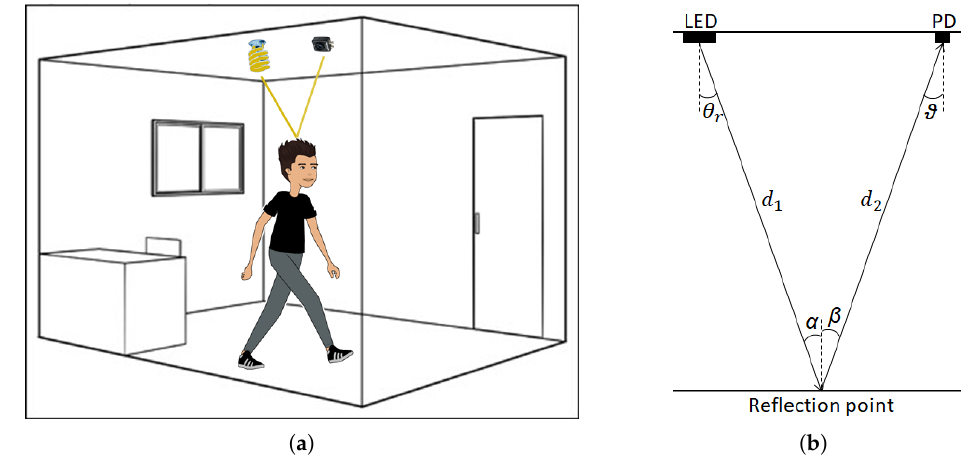
Figure 2. ( a ) One “perfect” light ray. One light and one PD are mounted at the ceiling. ( b ) A schematic diagram of Equation